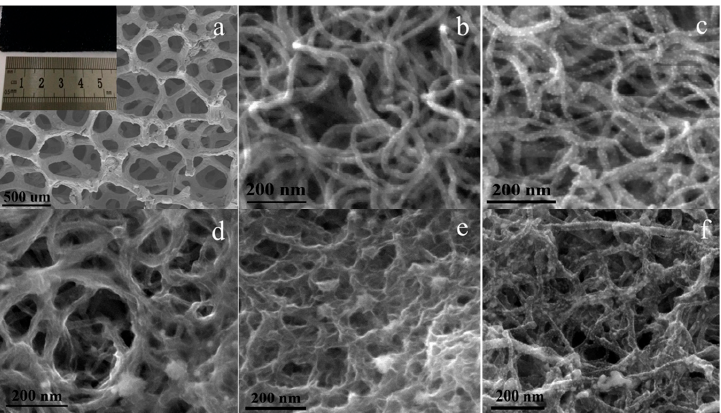
Figure 1. Field emission scanning electron microcopy (FESEM) images of 0.5 wt.% fresh ( a , c ), 0.2 wt.% fresh ( b ), 0.5 wt.% used ( d ), 0.5 wt.% deactivated with phenol ( e ) and 0.5 wt.% regenerated ( f ) Pd/carbon nanotube (CNT)-Ni foam micro reactors. The inset in ( a ) is the photograph of the Pd/CNT-Ni foam micro